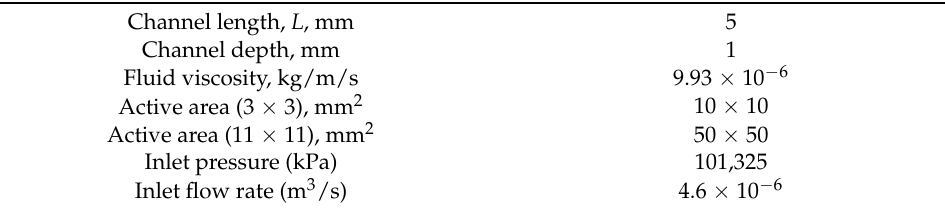
Table 1. Flow parameters.